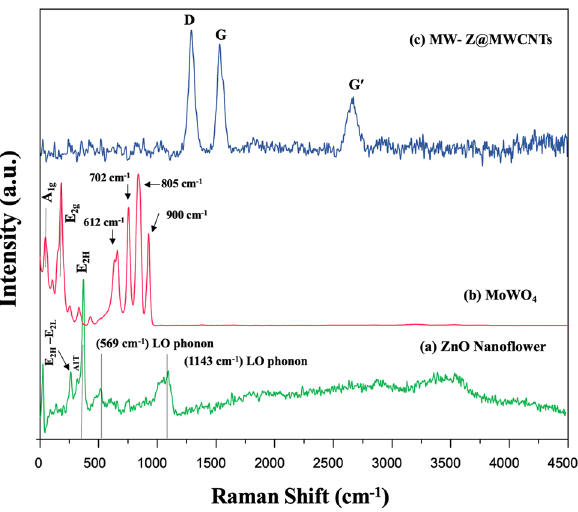
Figure 6. Raman spectra of ( a ) ZnO nanoflowers, ( b ) MoWO 4 , and ( c )